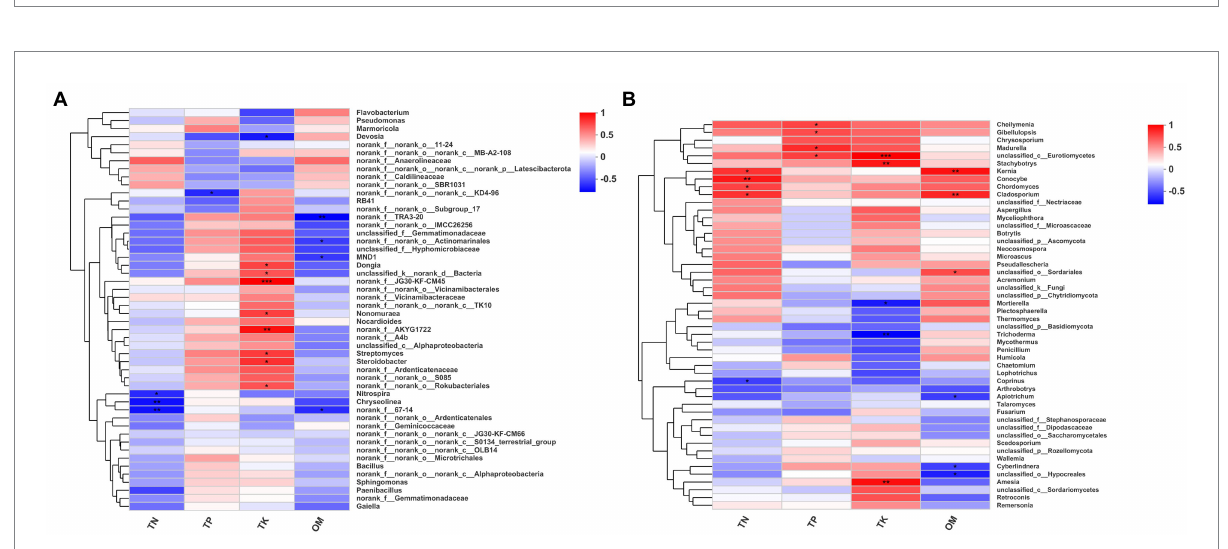
FIGURE 4 Correlation heat map of microbial classification and environmental factors. (A) Correlation heat map of the top fifty genera (bacteria) and environmental factors. (B) Correlation heat map of the top fifty genera (fungi) and environmental factors. The symbol (*) indicated that 0.01 < p ≤ 0.05, (**) indicated that 0.001 < p ≤ 0.01, (***) indicated that p ≤